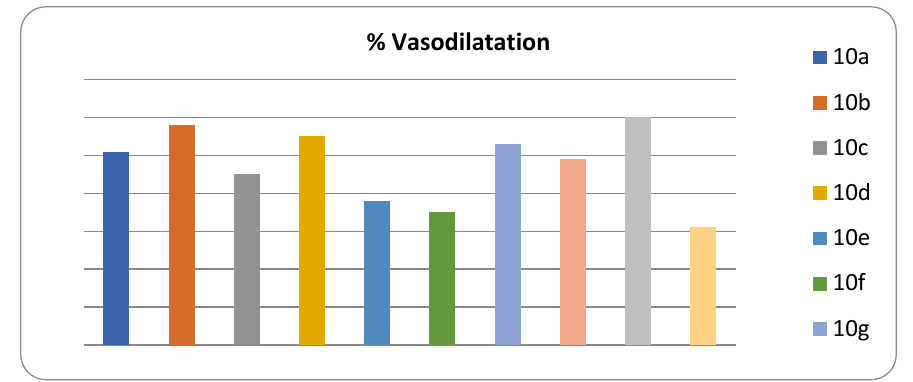
Figure 1. The % vasodilatation of 10a – j .